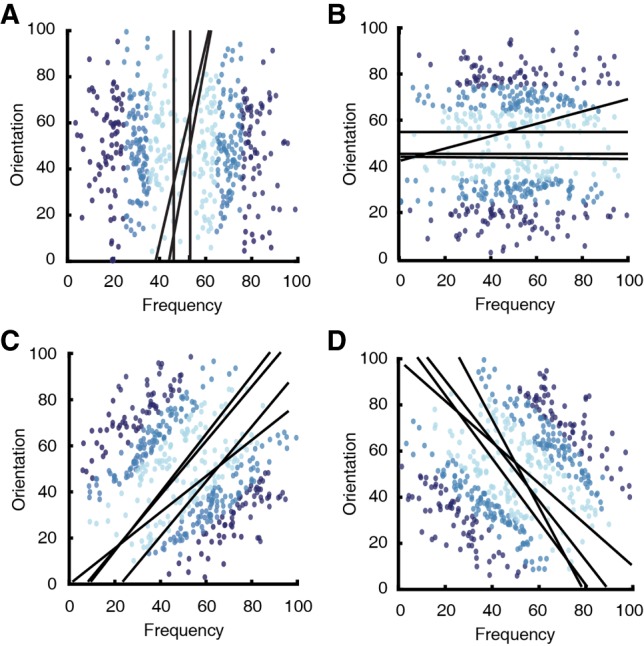
Estimated decision boundaries obtained from GRT. Three models were fit to each rat's generalization data: two models that assume a one-dimensional decision boundary (synonymous to a RB strategy) and one model that assumes a two-dimensional decision boundary (synonymous to an II strategy). The best fit was determined according to the model with the lowest AIC value. (A,B) The best fitting decision boundaries for rats learning a RB task. (C,D) The best fitting decision boundaries for rats learning an II task.